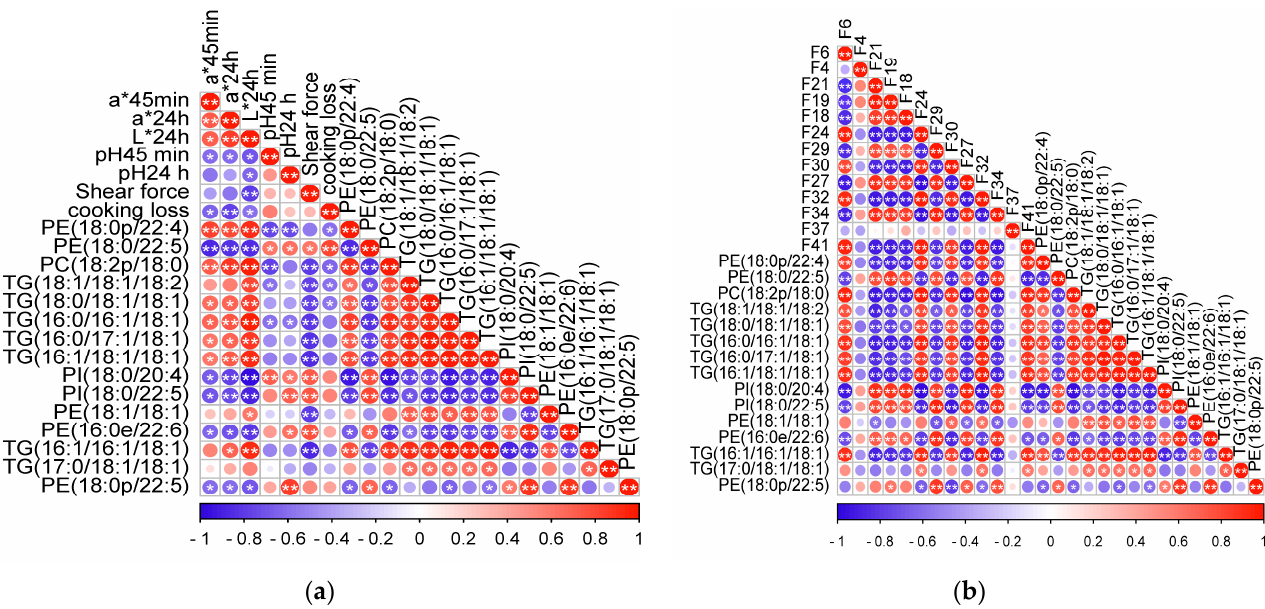
Figure 5. ( a ) The correlations of crucial lipids with meat quality. ( b ) The correlations of crucial lipids with volatile flavor compounds. * shows p < 0.05, and ** shows p < 0.01. Circles with no * or ** show p > 0.05. Red and blue represent positive and negative correlations, respectively. The deeper the color, the higher the correlation.